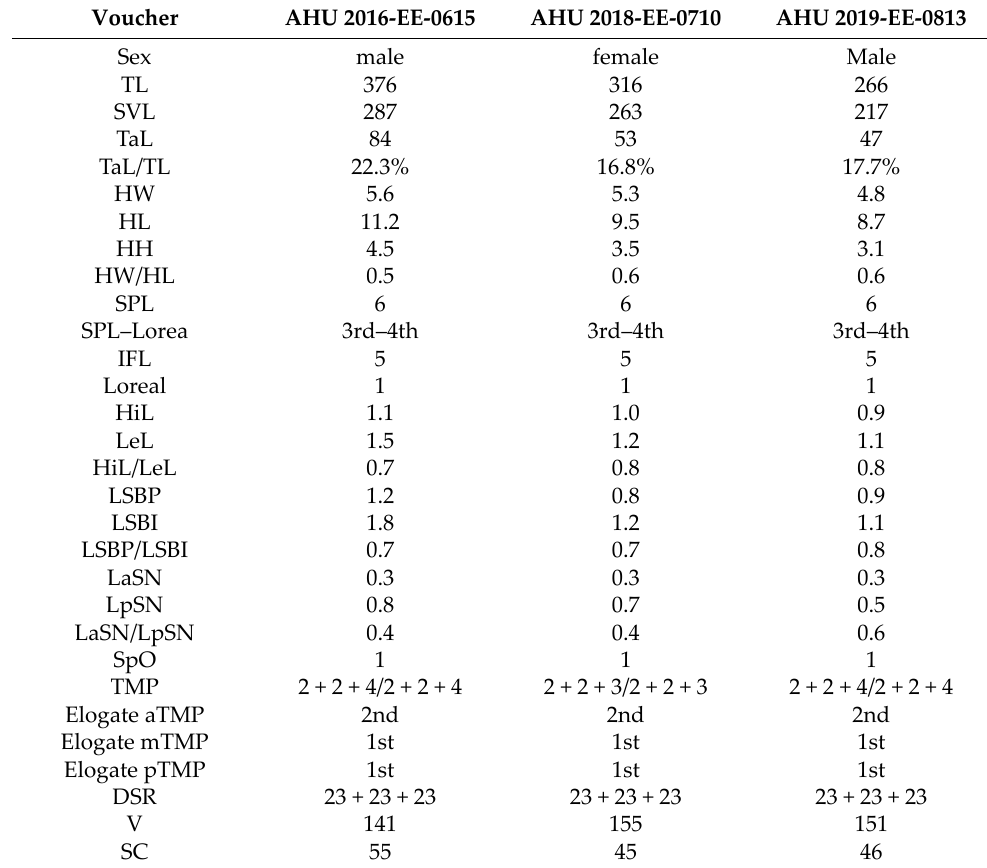
Table 3. Measurements, scale counts, body proportions, and squamae characters of the sample